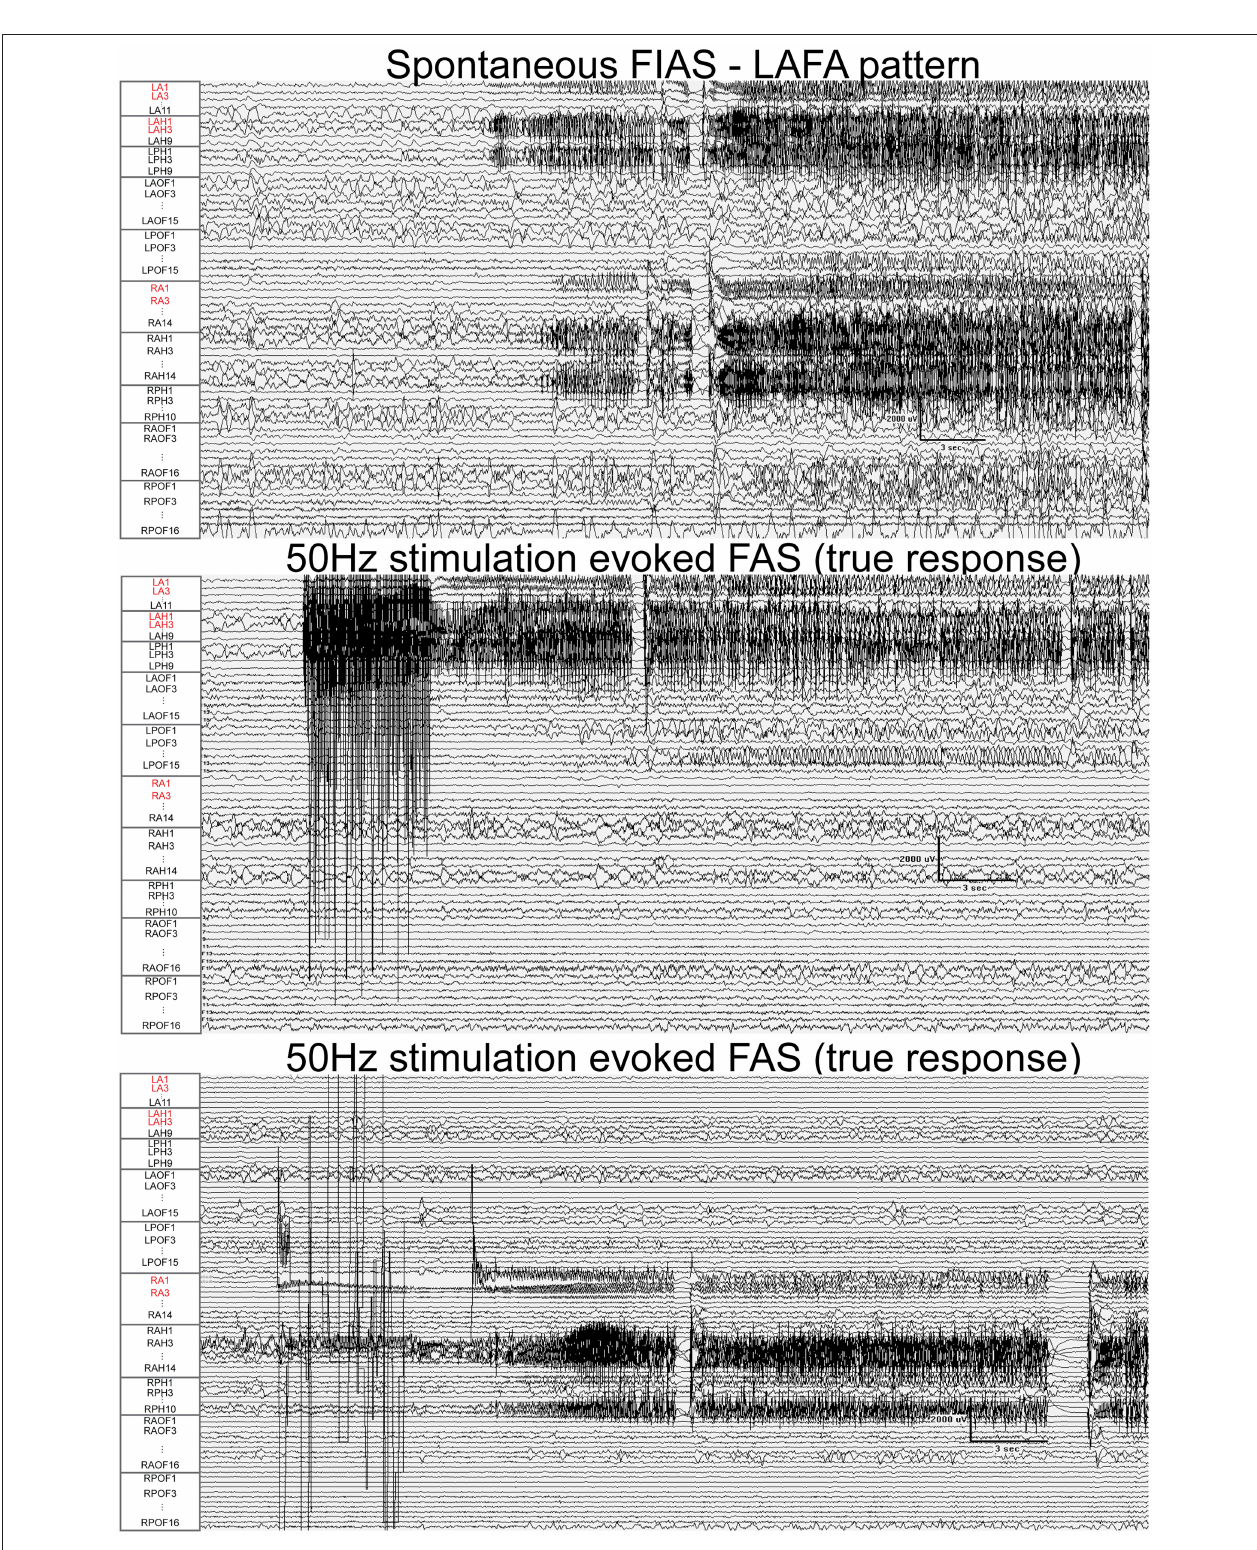
FIGURE 5 | FiftyHertz stimulation of left hippocampus and right amygdala evoked seizures (true responses) in a patient with bi-temporal epilepsy. Nodes with a high epileptogenicity index ( > 0.3) are highlighted in red. The spontaneous seizure had LAFA (low amplitude fast activity) pattern that emanated from the left hippocampus with a rapid propagation to the left amygdala, right amygdala, and hippocampus. FAS, focal seizure with retained awareness. FIAS, focal impaired awareness seizure.